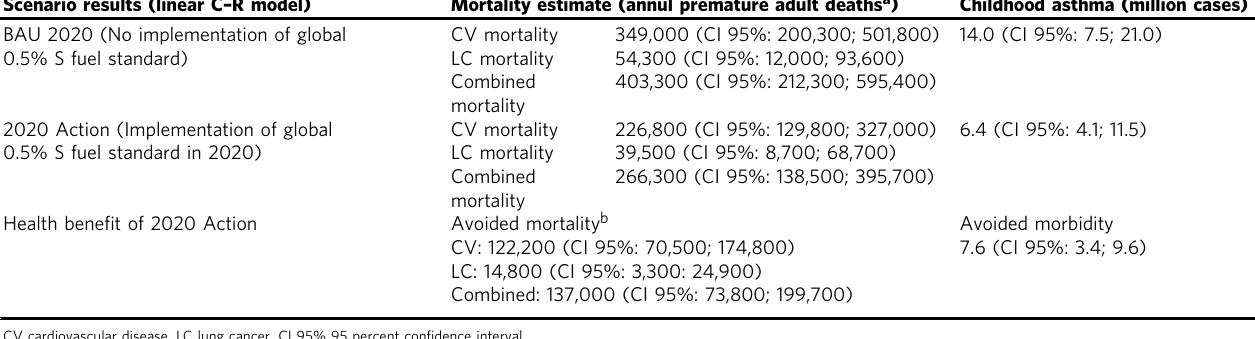
Table 2 Estimated annual health impacts of global shipping in 2020 in the BAU case and the 2020 Action case with IMO low- sulphur fuel standard, where parentheses indicate 95% con fi dence intervals based on relative risk calculations Scenario results (linear C – R